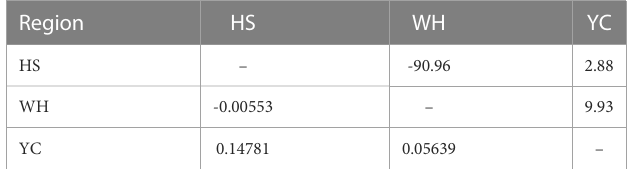
TABLE 5 Pairwise genetic differentiation (Fst: left bottom) and gene fl ow (Nm: upper right) among Neo fl abelliforma dubium n. sp. isolates based on Rpb1 gene. Region